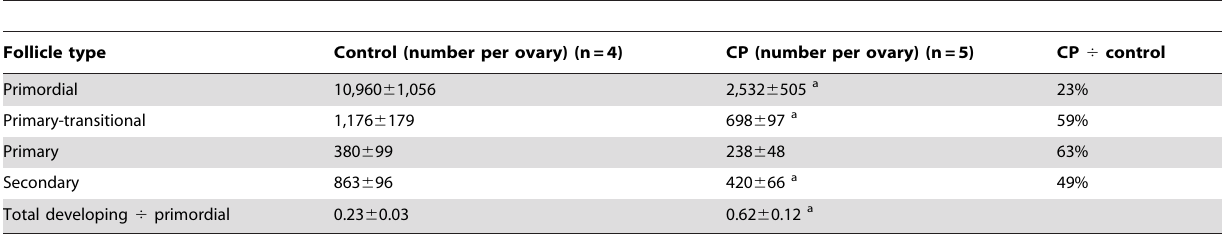
Table 5. Reduction of the number of primordial and developing follicles in the ovaries of 7-day- old 129S5 mice exposed to cyclophosphamide (CP) in utero